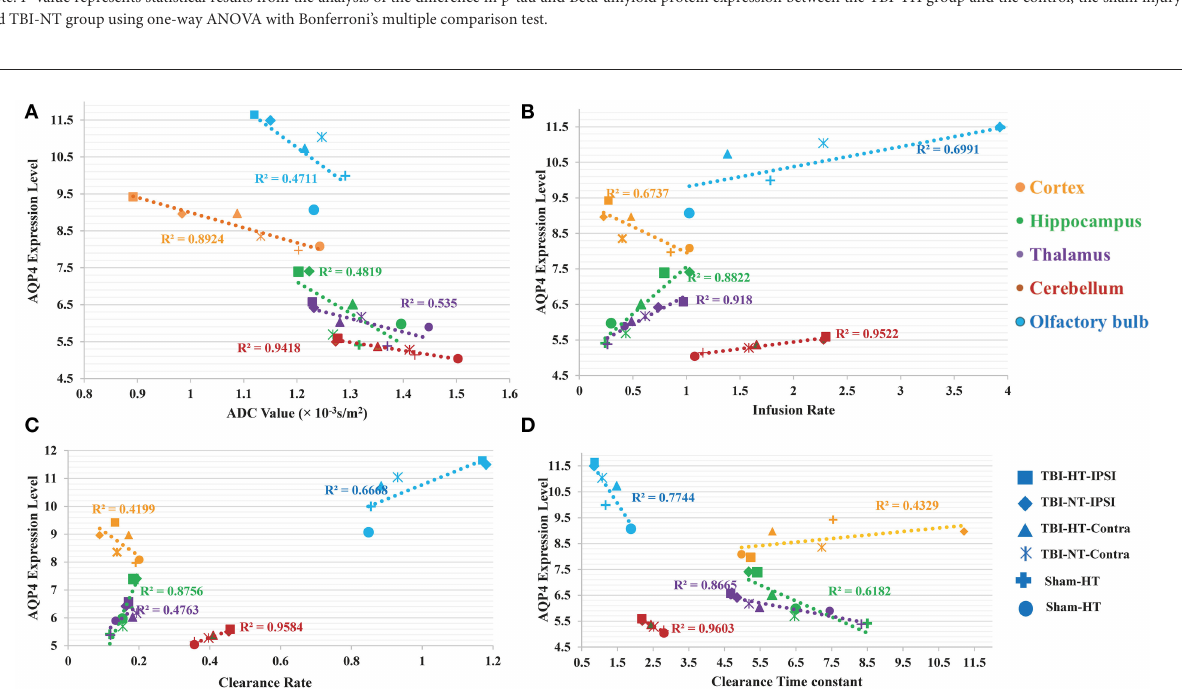
FIGURE12 The correlation between APQ4 expression level with glymphatic dysfunction and ADC value is described in scatter plot graphs (A–D) . Scatter plot graphs show the APQ4 expression level in five brain subregions are linearly related to (A) ADC value (B) Infusion rate (C) Clearance rate, and (D) Clearance time constant of sham control, TBI-NT, and TBI-HT rats ( r 2 = 0.89, 0.48, 0.54, 0.94, 0.47 for ADC value, r 2 = 0.67, 0.88, 0.92, 0.95, 0.70 for Infusion rate, r 2 = 0.42, 0.88, 0.48, 0.96, 0.67 for Clearance rate and r 2 = 0.43, 0.62, 0.87, 0.96, 0.77 for clearance time constant in cortex, hippocampus, thalamus, cerebellum, and olfactory bulb, respectively, all p < 0.01, Spearman’s correlation test, n =